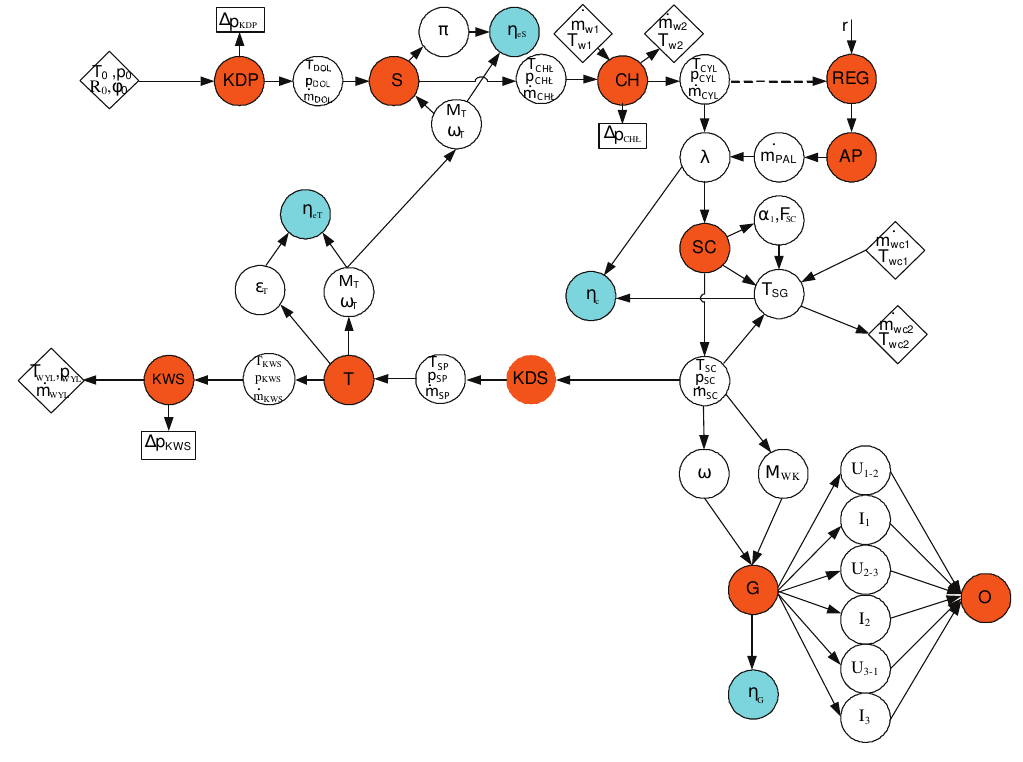
Fig. 3. Topological model of the marine generator